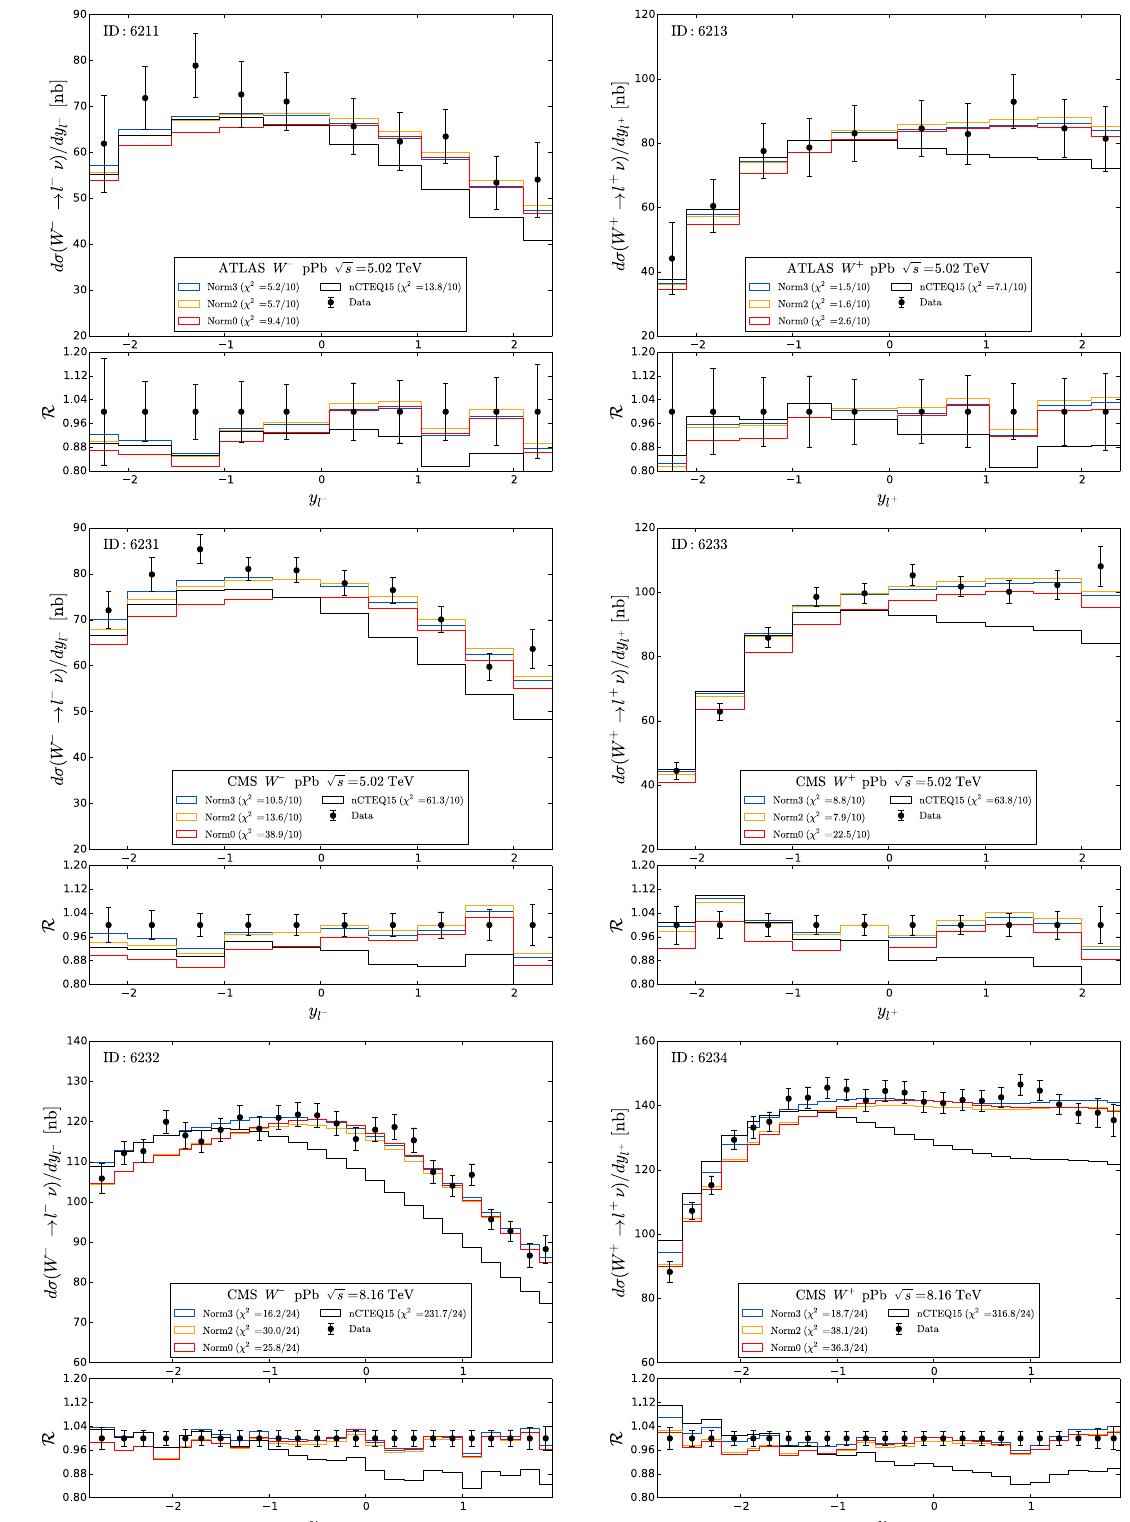
Fig. 3 Comparison of data with theory for ATLAS and CMS W ± production. The normalization shifts are applied to the theory so we can compare all the results on a single plot; the data is unal-